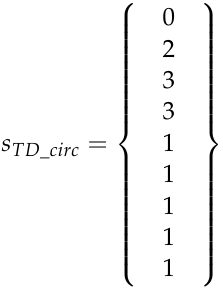
Figure 18. State of the borehole at the end of the circulation cycle.